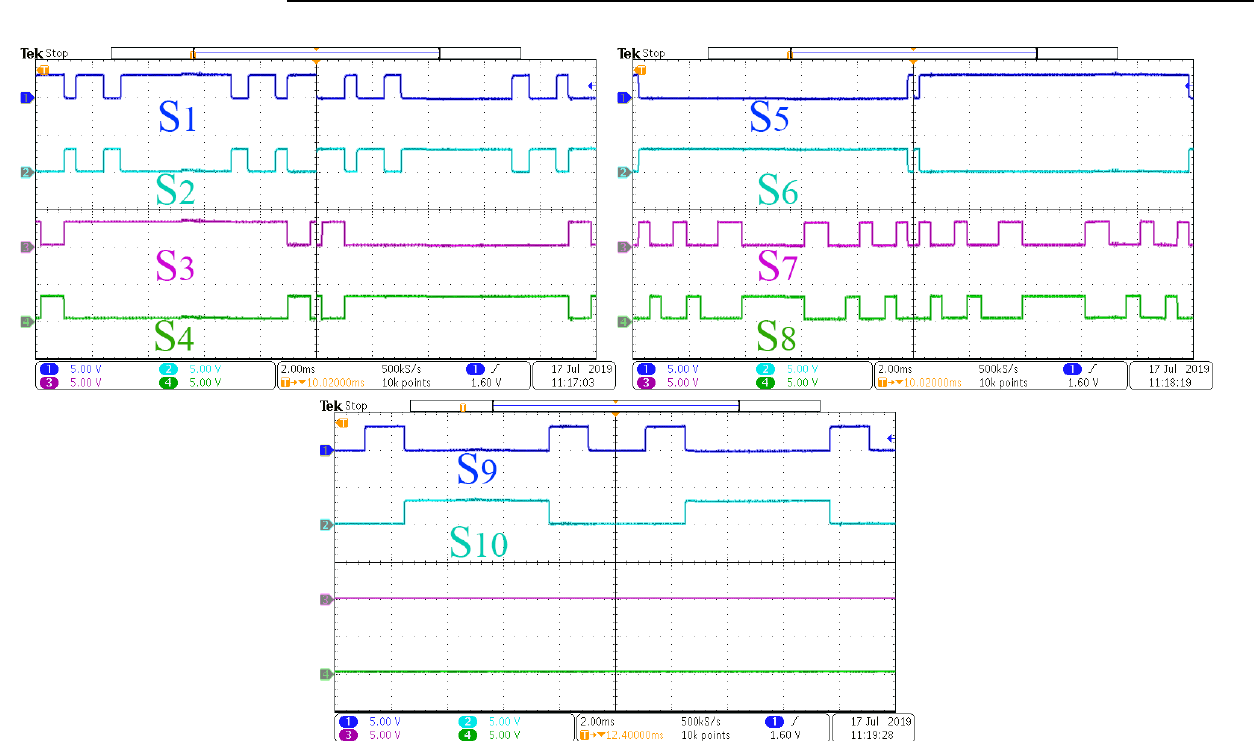
Figure 13. Experimental switching